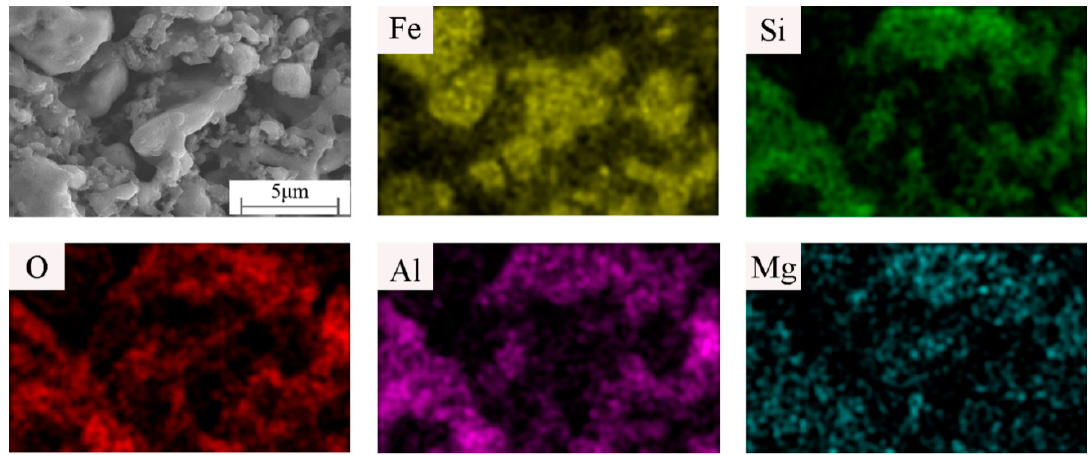
Figure 8. EDS elemental scans of samples prepared with the microwave susceptor as AC/SiC = 1 hybrid.